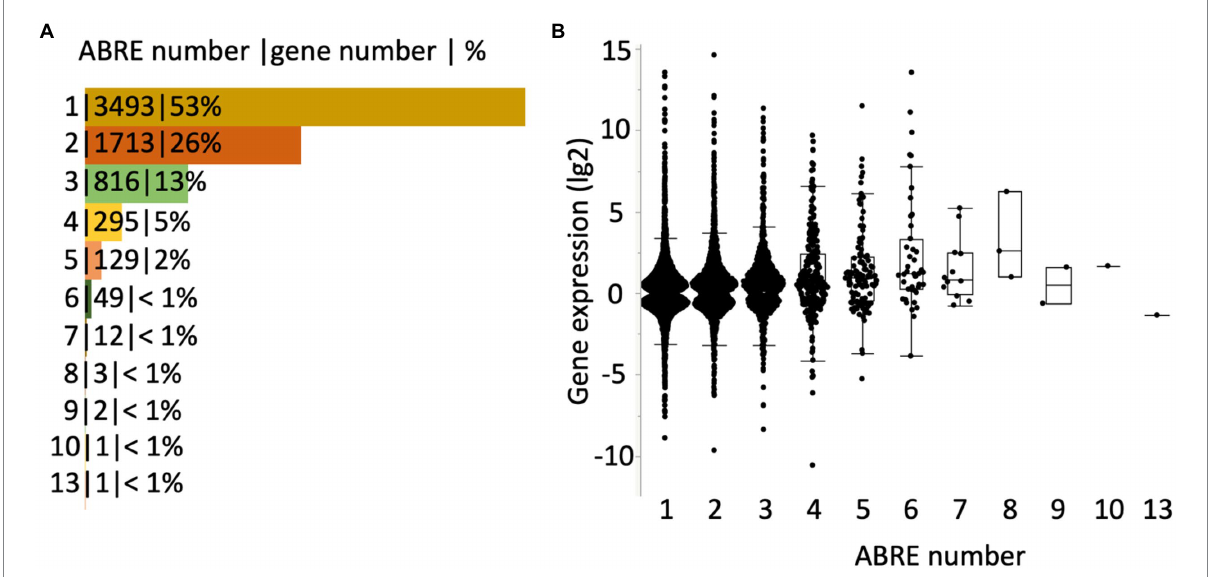
FIGURE 2 Genes regulated through ABRE-ABF binding in Arabidopsis. (A) Genes in the ABA GRN (Sun et al., 2022) are categorized by the number of ABRE in their gene body. The number of genes belonging to each category and percentage in the ABA GRN is shown with a separate marker “|.” The bars in the figure indicate the percentages. (B) Box plots of genes in the ABA GRN. X-axis variables are the number of ABRE in a gene. Y-axis variables are changes in gene expression (lg2) by ABA in root tissue (3 h after the ABA treatment). Black dots indicate points of individual genes. All genes in the ABA GRN are listed, together with gene expression in root and shoot tissues at different time points, in Supplementary Table